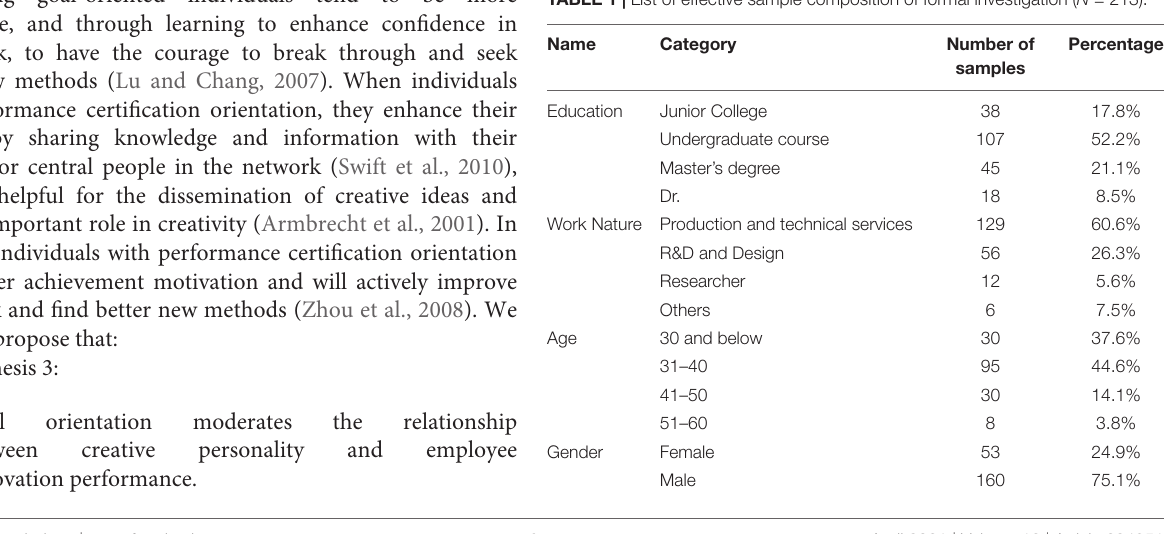
TABLE 1 | List of effective sample composition of formal investigation ( N =